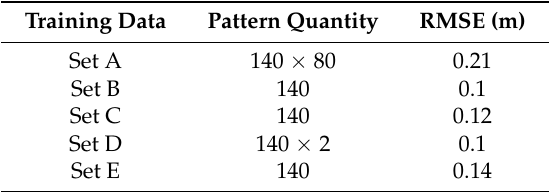
Table 1. Performance comparison of different training data sets.